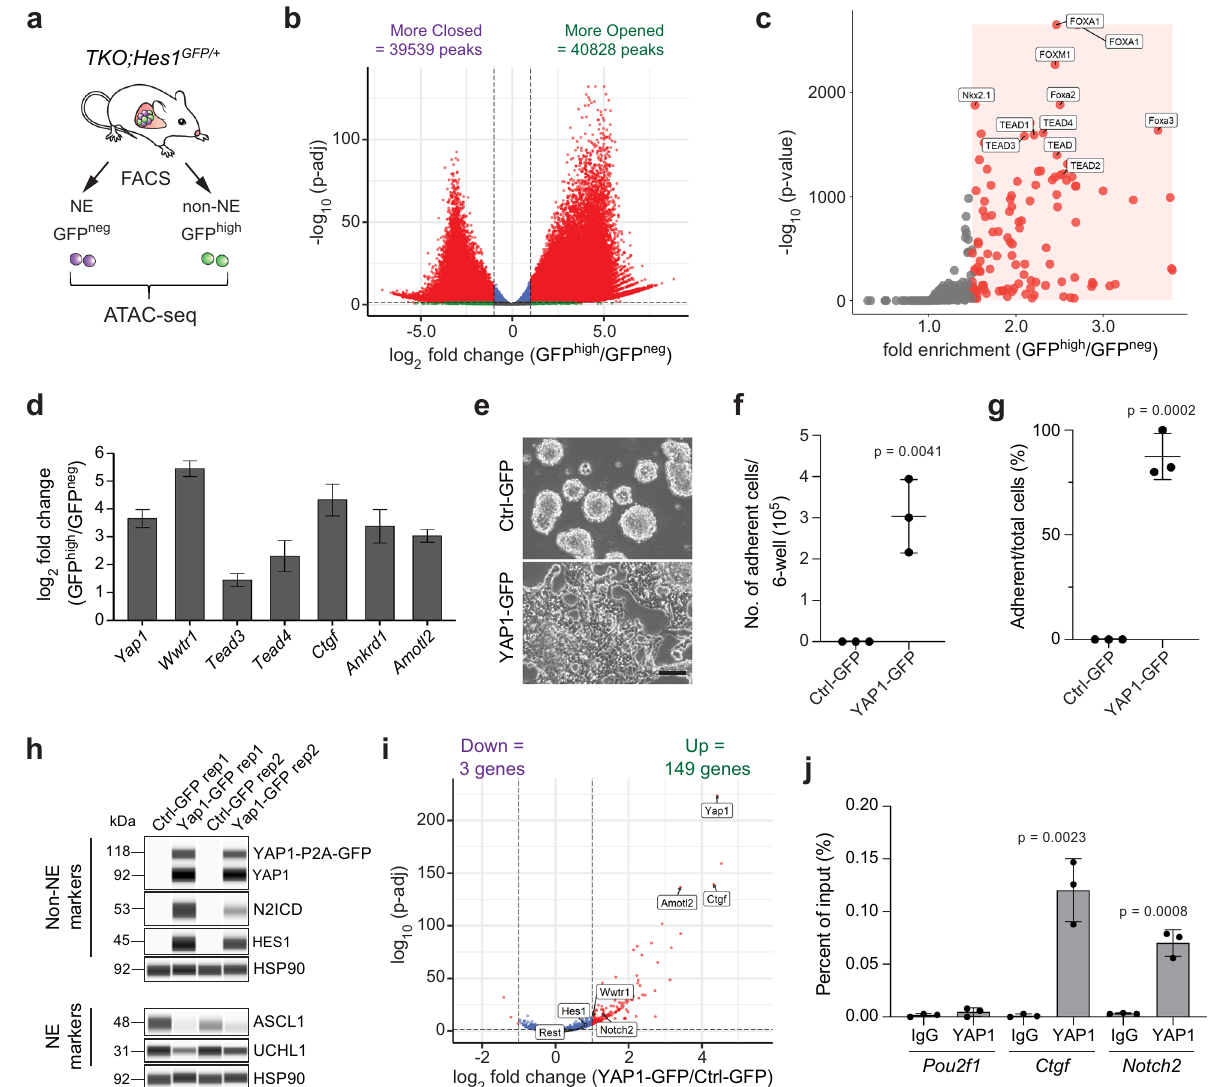
Fig. 6 YAP1 promotes the transdifferentiation of SCLC cells to a non-neuroendocrine fate. a Schematic representation of neuroendocrine (NE) and non- NE SCLC cells isolated from the TKO ; Hes1 GFP/ + mouse model for ATAC-seq. b Volcano plot of differentially accessible peaks from the ATAC-seq data comparing non-NE SCLC cells to NE SCLC cells (signi fi cant peaks with more than 2-fold change and p -adj value < 0.001 are in red). Wald test with Benjamini – Hochberg correction. c Scatterplot showing the enriched motifs identi fi ed by HOMER analysis on the more open peaks in non-NE SCLC cells (signi fi cant motifs with more than 1.5-fold change and p -value < 0.001 are in red). d Expression of Hippo pathway members and targets from RNA-seq data in GFP high cells compared to GFP neg cells ( n = 4). Error bars, log2 fold change estimate ± SE. e – g , e Representative bright fi eld images of NE mouse KP1 SCLC cells 14 days after Ctrl-GFP (control) or YAP1-GFP overexpression. Scale bar, 100 μ m. Quanti fi cation of the number of adherent cells counted per well of a 6-well plate ( f ) and the percentage of cells that became adherent ( g ) as in ( e ) ( n = 3 independent experiments). Unpaired t -test, data represented as mean ± s.d. h Immunoassay of non-NE and NE markers in KP1 cells after overexpression of either Ctrl-GFP or YAP1-GFP (4 weeks). Bands of two molecular weights are detected with the antibody against YAP1 due to some incomplete cleavage of P2A. Samples from n = 2 independent experiments. i Volcano plot of differentially expressed genes from RNA-seq data of 5 days overexpression of YAP1 in KP1 cells. Notch2 , Hes1 , Rest and Hippo pathway members are highlighted (signi fi cant genes with more than 2-fold change and p -adj value < 0.05 are in red). Wald test with Benjamini – Hochberg correction. j ChIP-qPCR analysis of YAP1 binding at the promoters of Pou2f1 (negative ctrl), Ctgf (positive ctrl) and Notch2 in independently generated GFP high cell lines from TKO ; Hes1 GFP/ + mouse SCLC tumors ( n = 3). Unpaired t -test, data represented as mean ± s.d. See also Supplementary Fig. 9 and Supplementary Data 12 and 13. Source data are provided as a Source Data fi le. mice but not Yap1 mutant mice. Furthermore, lineage-labeled cells the NE to non-NE transition in response to naphthalene injury in with CC10 expression also co-expressed YAP1 whereas those that the lung epithelium. did not transdifferentiate remained YAP1 negative (Fig. 7a, b). In addition, quanti fi cation of Tomato-positive clusters in the lungs by whole mount imaging showed reduced numbers of large Tomato- positive clusters in Yap1 mutant mice compared to controls (Fig. 7c, d). These experiments indicate that Yap1 is required for driven cell fate changes in normal tissues has often been limited NATURE COMMUNICATIONS| (2022) 13:2690